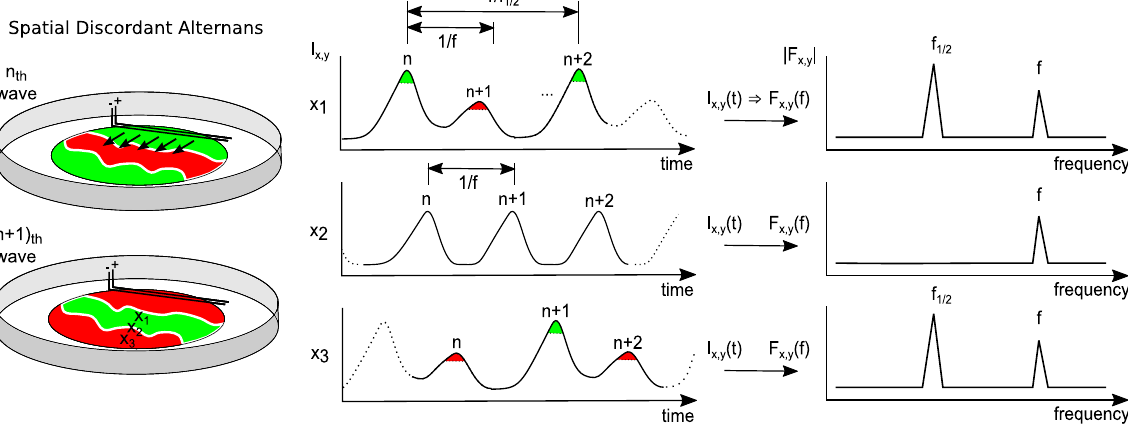
Figure 1. Schematic illustration of spatially discordant alternans in high-frequency oscillatory cardiac tissue. The three time series illustrate the temporal intracellular calcium release at three spatially different positions. Positions x 1 and x 3 are spatially separated by the nodal line (x 2 ). The black arrows illustrate the direction of wave propagation originating from the electrode. The three frequency spectra on the right side show the respective amplitudes | F x , y ( f )|. In case of period-1 oscillations (nodal lines, x 2 ) no frequency- peak at f 1/2 is detected and f is the rotational frequency of the spiral wave. Thus, a spatial amplitude map at f 1/2 will reveal the nodal lines as low amplitude (low energy) bands in the tissue. (For a more detailed example that compares normal wave conduction, spatially discordant and spatially concordant alternans, see the supplemental material, Fig.